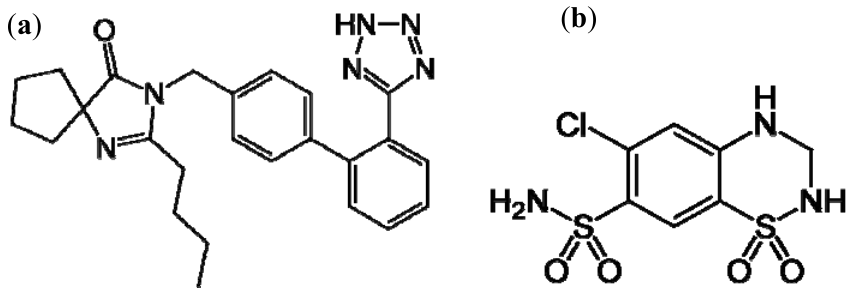
Figure 1. Structural formulae of irbesartan ( a ) and hydrochlorothiazide ( b